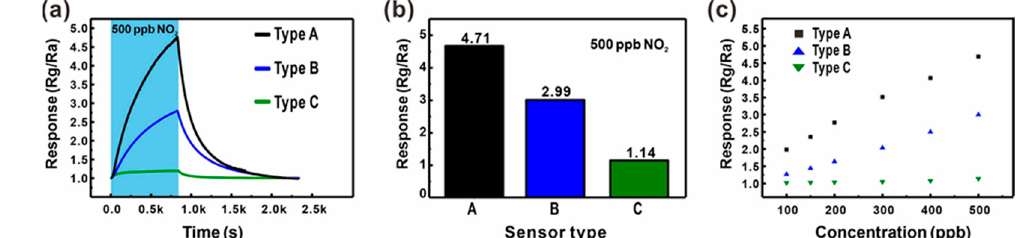
Figure 5. ( a , b ) Comparison of the gas sensing responses of three different types of ZnO NW networks (Type A: ZnO NW networks on a suspended carbon mesh with large voids (blue); Type B: ZnO NW networks on a suspend carbon mesh with small voids (black); Type C: ZnO NW networks on the substrate (green)) for 500 ppb NO 2 mixed in dry air. ( c ) Comparison of the gas responses to various NO 2 concentrations (100–500 ppb) mixed in dry air.